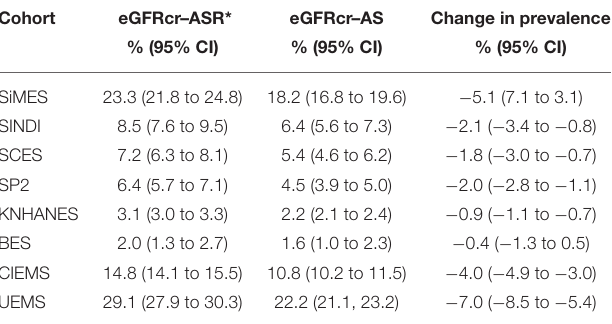
TABLE 2 | Estimated Prevalence of eGFR Categories G3-G5 (eGFR < 60 mL/min/1.73 m 2 ) in the study cohorts. Cohort